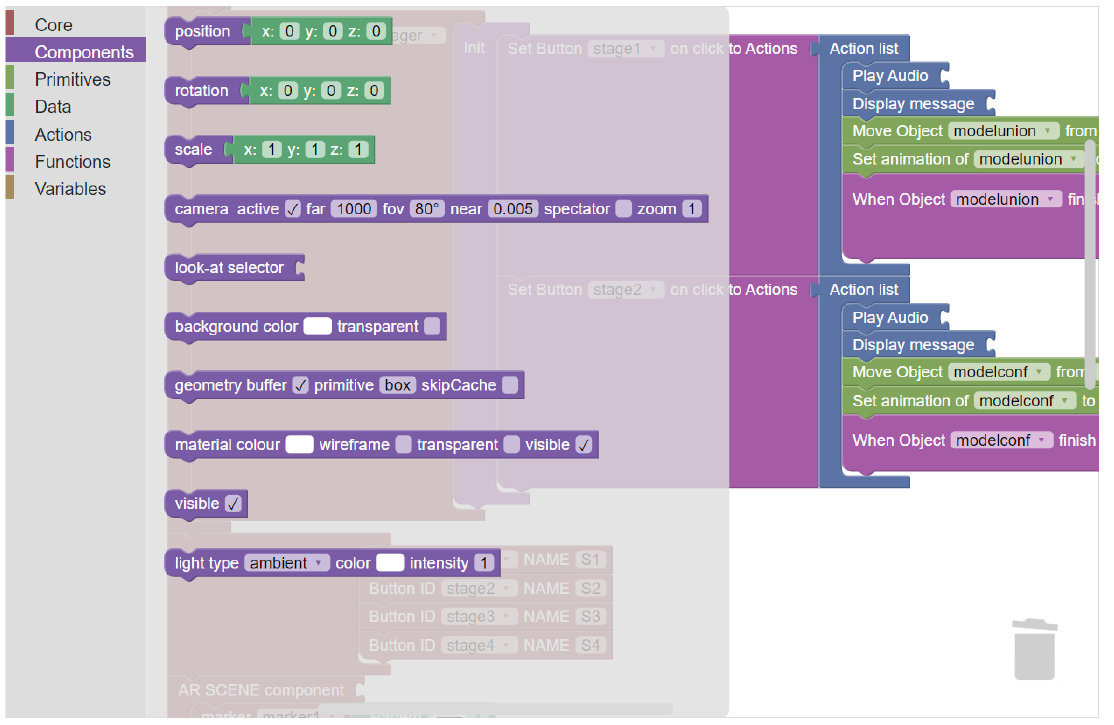
Figure 3. The coding editor of BlocklyAR enables users to drag and drop a palette of commands into the working